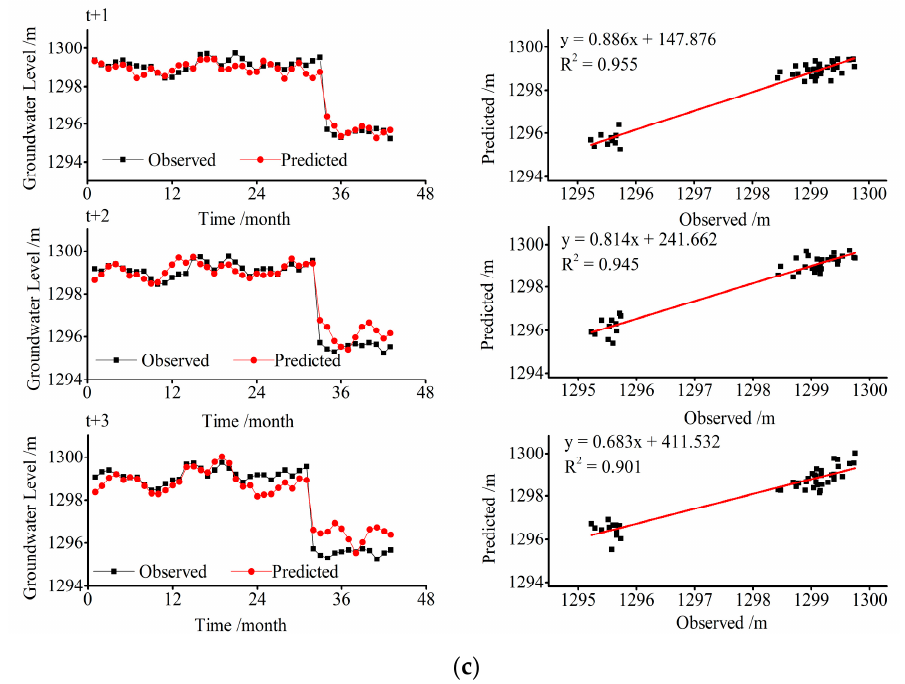
Figure 6. Observed groundwater level and forecasted by VELM model for 1, 2 and 3-months ahead during the testing period at Well I ( a ), Well II ( b ) and Well III ( c ).